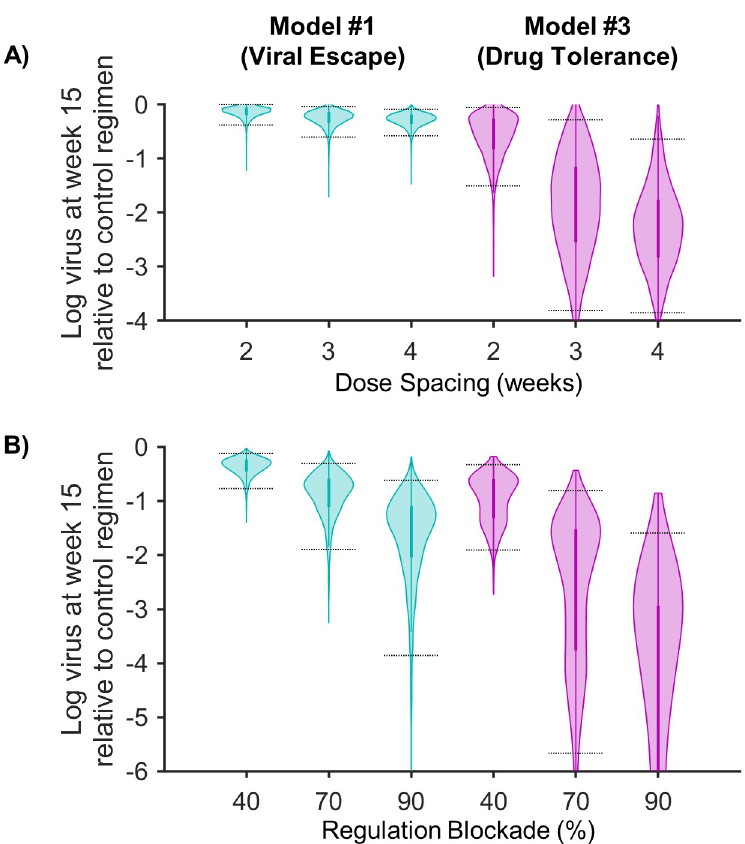
Fig 8. Potential for regimen changes to improve N-803 treatment outcome. Shown is a summary of the results of treatment exploration for both the model with immune regulation and viral escape (model #1, left column) and the model with immune regulation and drug tolerance (model #3, right column). Both panels show the log difference in viral load at week 15 as compared to the control regimen (Fig 2 dosing schedule, with no regulation blockade). Panel (A) shows the difference with 2-, 3-, and 4-week dosing regimens. Panel (B) shows the difference with 40, 70 and 90% regulatory blockade (% reductions of killing regulation parameter λ ). Bayesian 95% credible intervals are marked. With the exception of changing dose spacing for model #1 (panel A, left), all results were different from zero and different from each other with p < 0.01. (See S1 Appendix for statistical method).